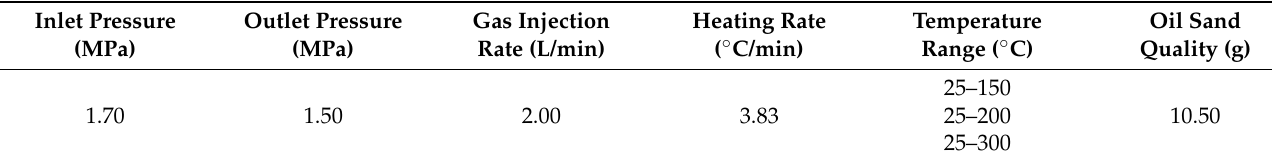
Table 2. Parameters of the kinetic cell